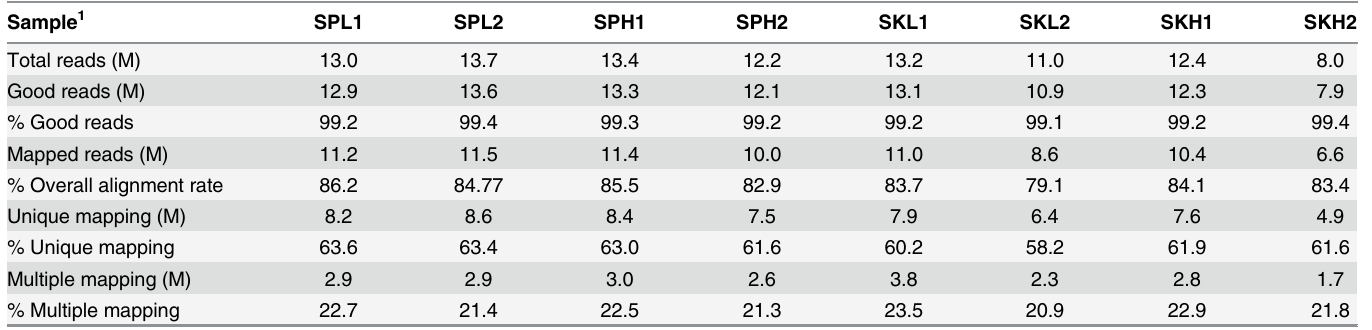
Table 2. Statistics for the filtering and mapping of reads to the reference chicken genome. Sample